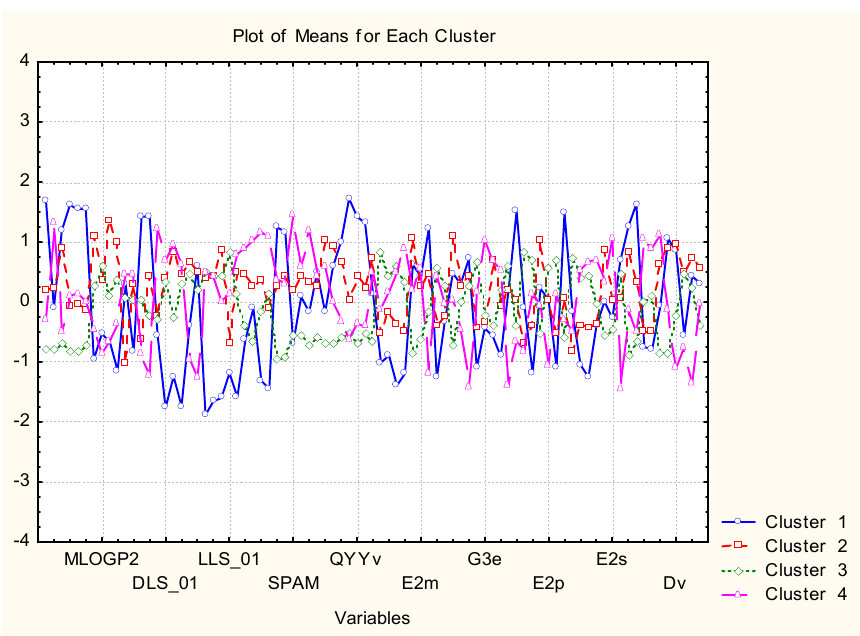
Figure 15. Plot of average (standardized) values of each variable for each identified cluster of objects. Cluster 1 (different from the other three similarity patterns) is characterized most typically by the highest values for MW, RBN, TPSA, HBA, HBD, QXXv, QYYv, L2p, P2s, and lowest values for DLS_01, DLS_02, DLS_03, DLS_06, DLS_07, DLS_conc, LLS_01, LLS_02, CMC_50, CMC_80.